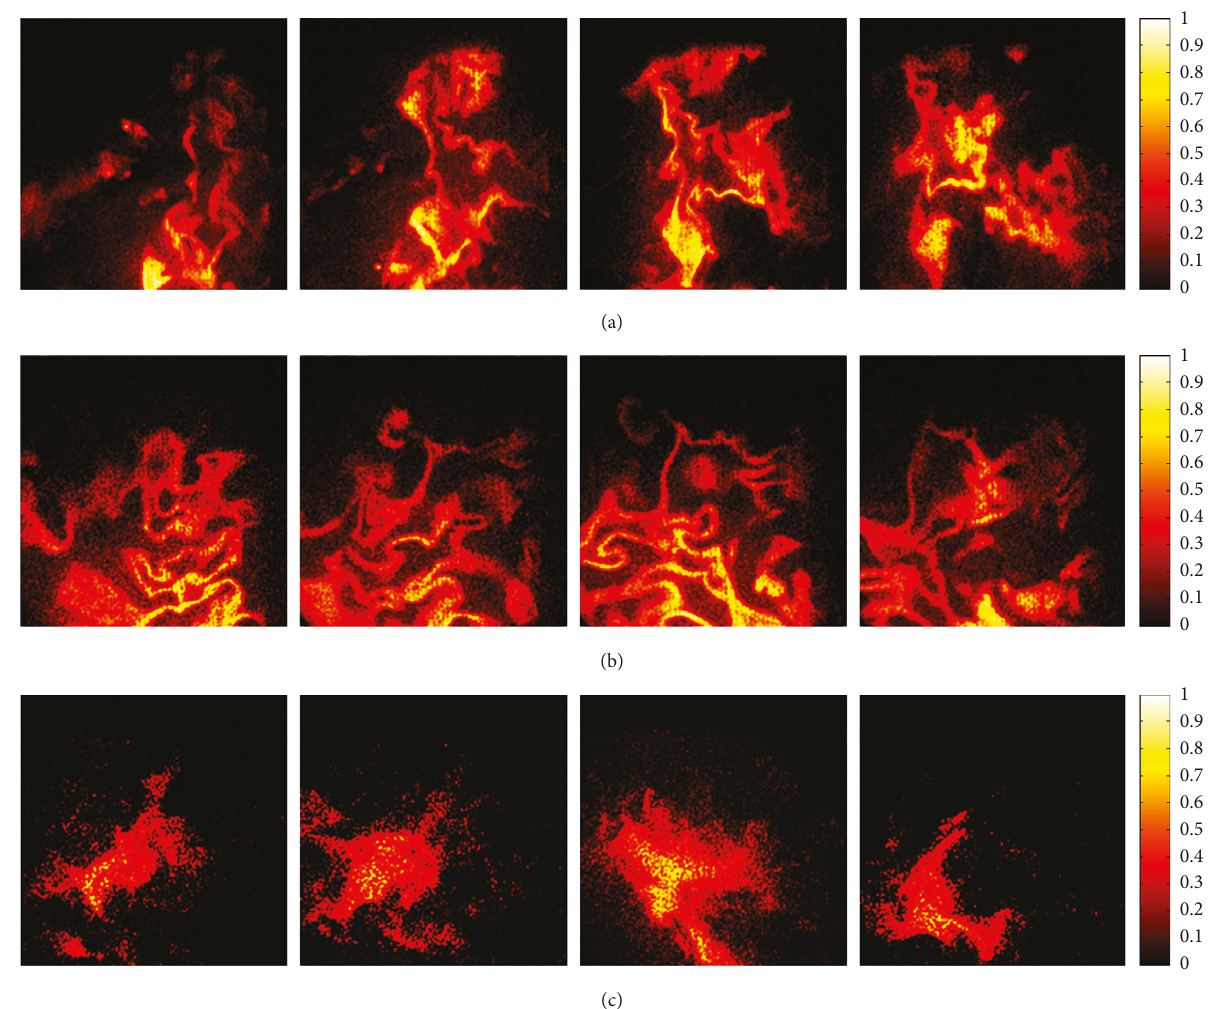
Figure 2: Selected sequences of OH-PLIF images. (a) In the O 2 /N 2 atmosphere, the oxygen concentration is 33% corresponding to the condition A1; (b) in the O 2 /CO 2 atmosphere, the oxygen concentration is 33% corresponding to the condition A2; (c) in the O 2 /CO 2 atmosphere, the oxygen concentration is 37% corresponding to the condition A3. The unit scale bar reflects the intensity of the OH signal, which has been